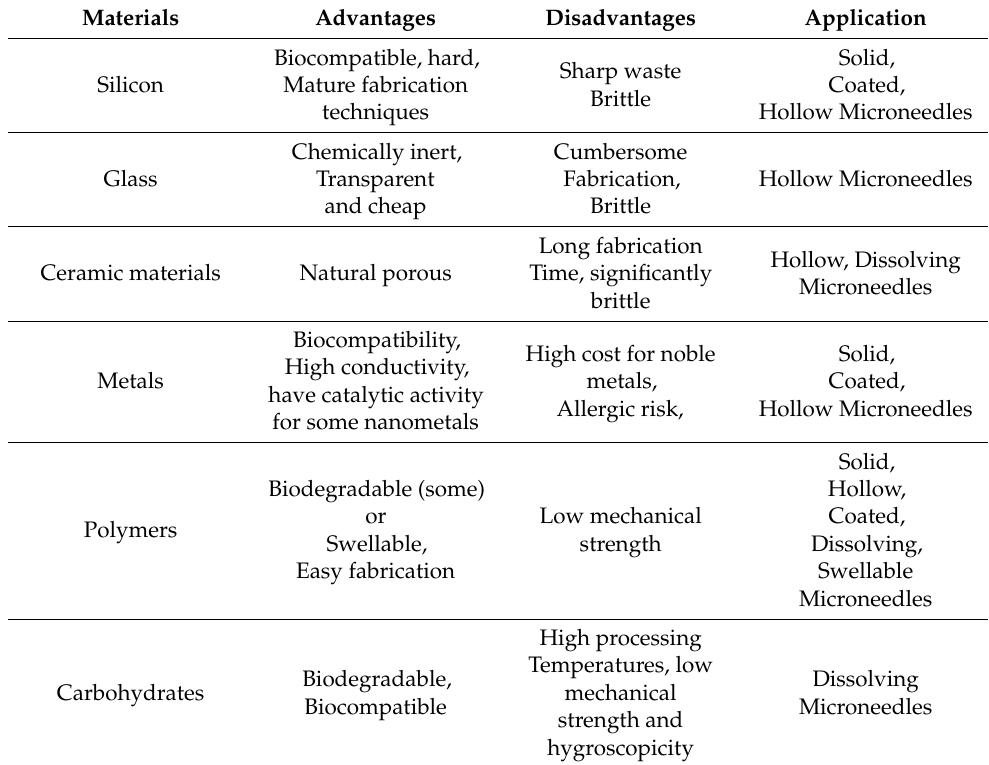
Table 3. Materials for the fabrication of solid microneedles